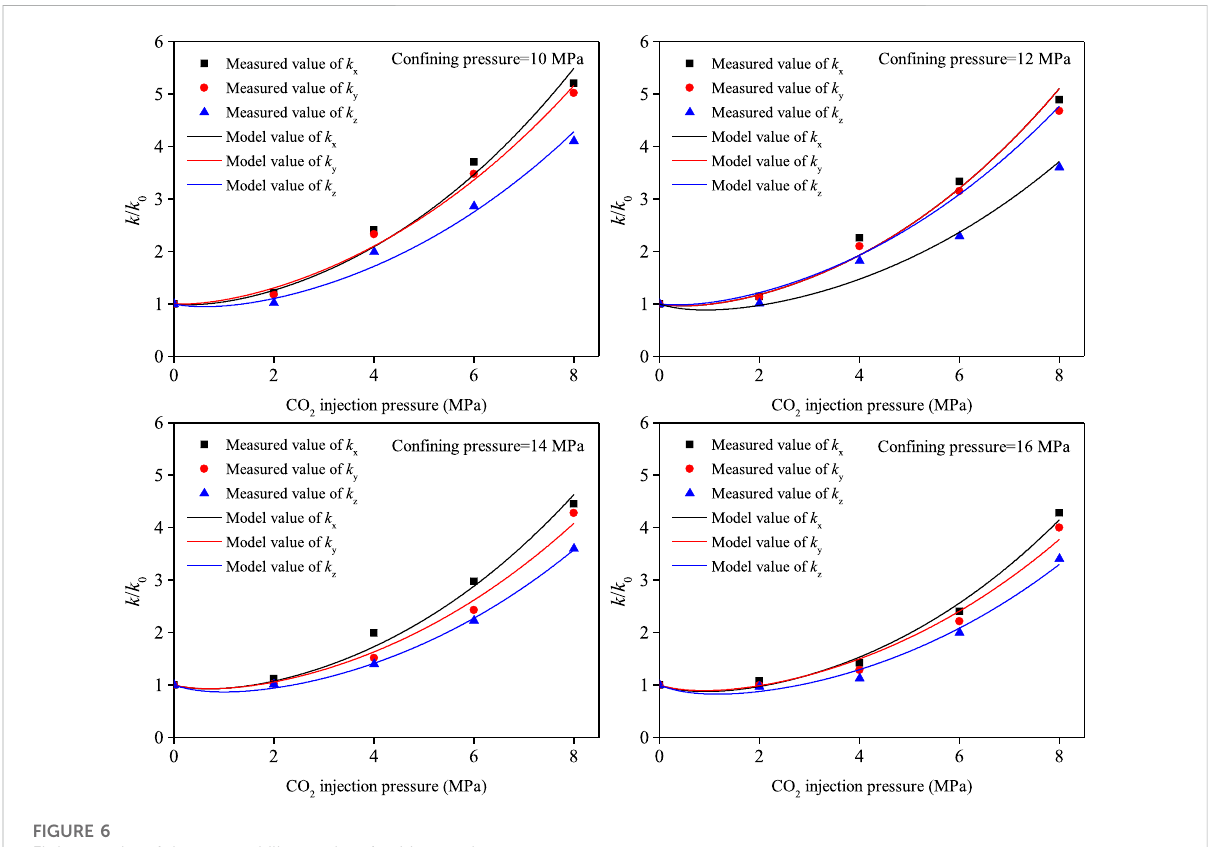
FIGURE 6 Fitting results of the permeability results of cubic